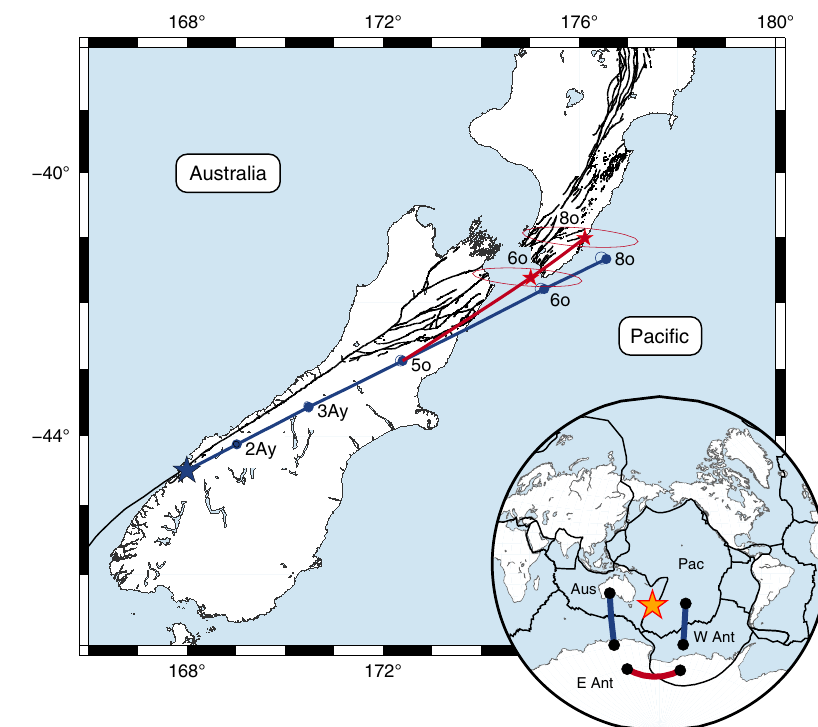
Fig. 6 Paci fi c-Australia plate motions during the Neogene. Predicted plate motion trajectories for the Paci fi c Plate relative to the Australian Plate shown for a point along the New Zealand Alpine Fault. The blue line shows the trajectory calculated by the summation of Australia-Antarctic 30 and Antarctic- Paci fi c 42 motions, assuming that Antarctica was a single plate. Inclusion of East-West Antarctic motion between anomalies 8o and 5o (Table 1) results in the red trajectory for the early